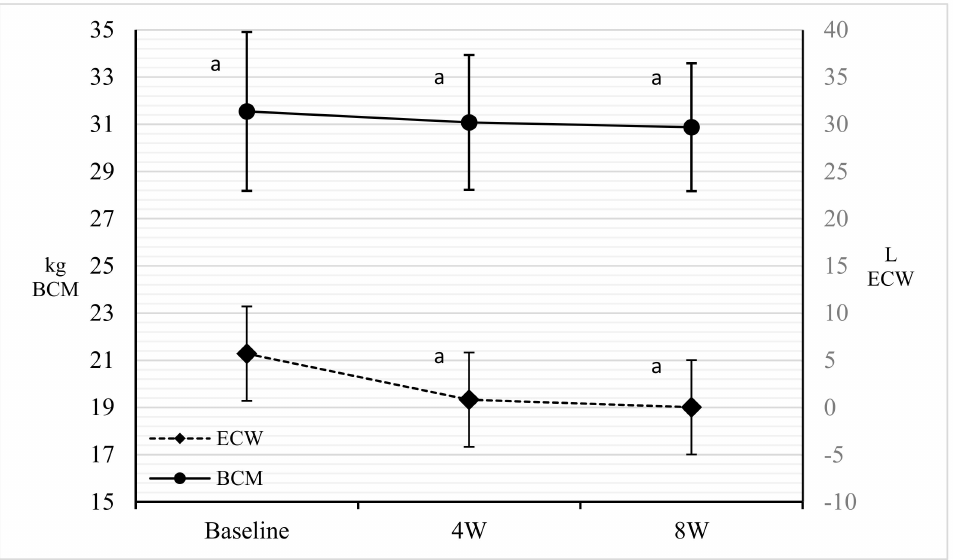
Figure 3. Comparison among baseline, four weeks, and eight weeks for ECW (L) and BCM (kg). Points sharing the same superscript letter are not significantly di ff erent from each other. Statistical significance attributed to results with p < 0.05. ECW: Extra Cellular Water; BCM: Body Cell Mass; 4W: 4 weeks; 8W: 8